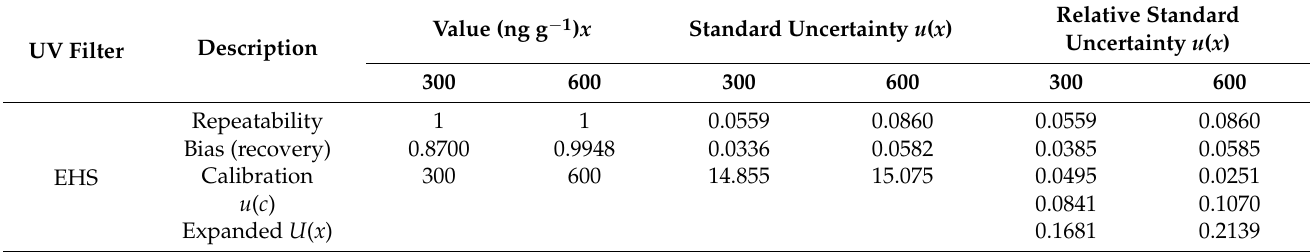
Table 6. Expanded uncertainties of QuEChERS followed by the in-port derivatization method for studied